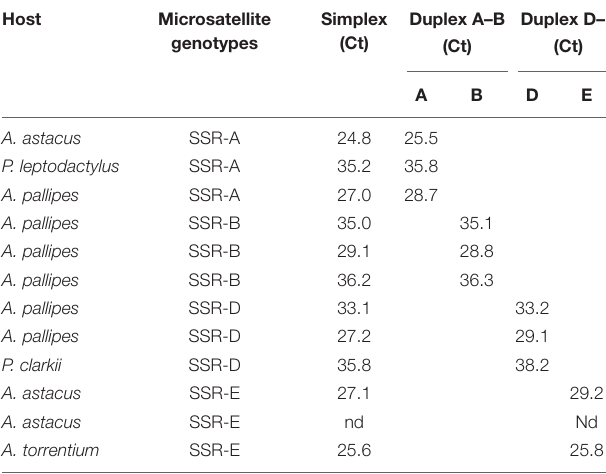
Assays A and D were labeled with JOE, while B and E were labeled with FAM at the 5 (cid:48)